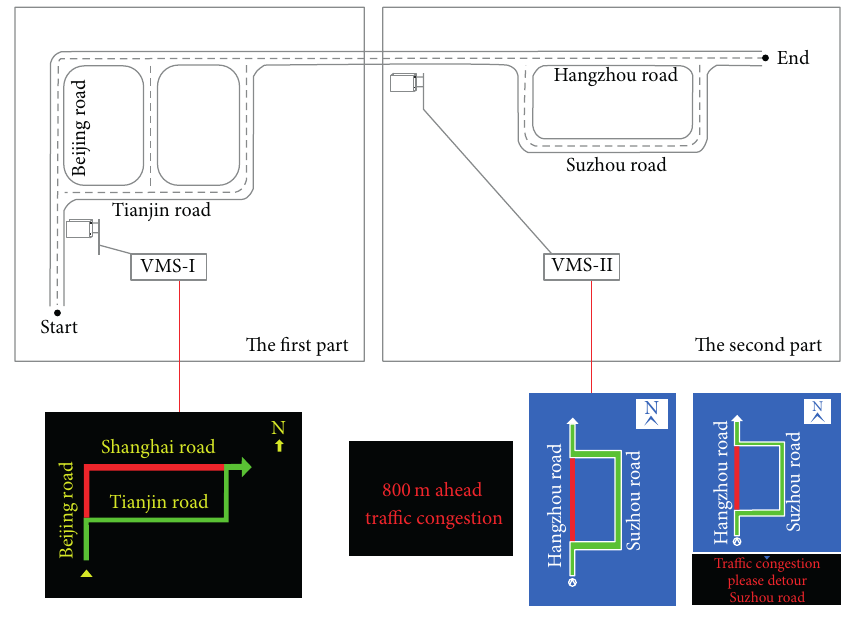
Figure 2: The experimental road network.